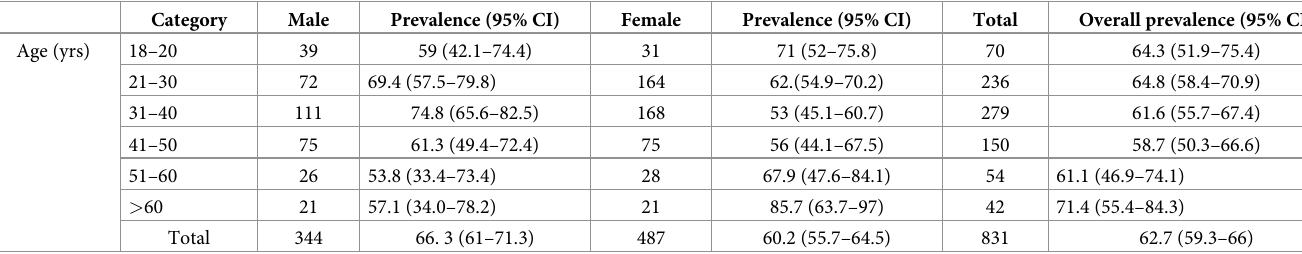
Table 2. Unadjusted Seroprevalence of COVID-19 in Bangalore rural district, India.